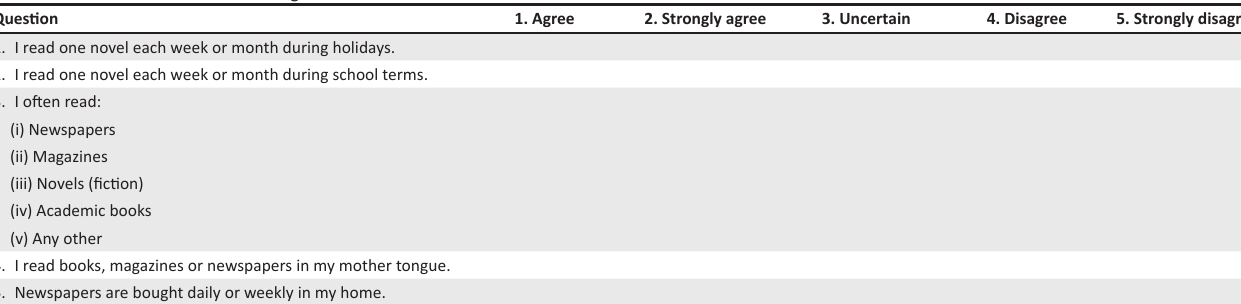
TABLE 1: Questions on students’ reading habits.